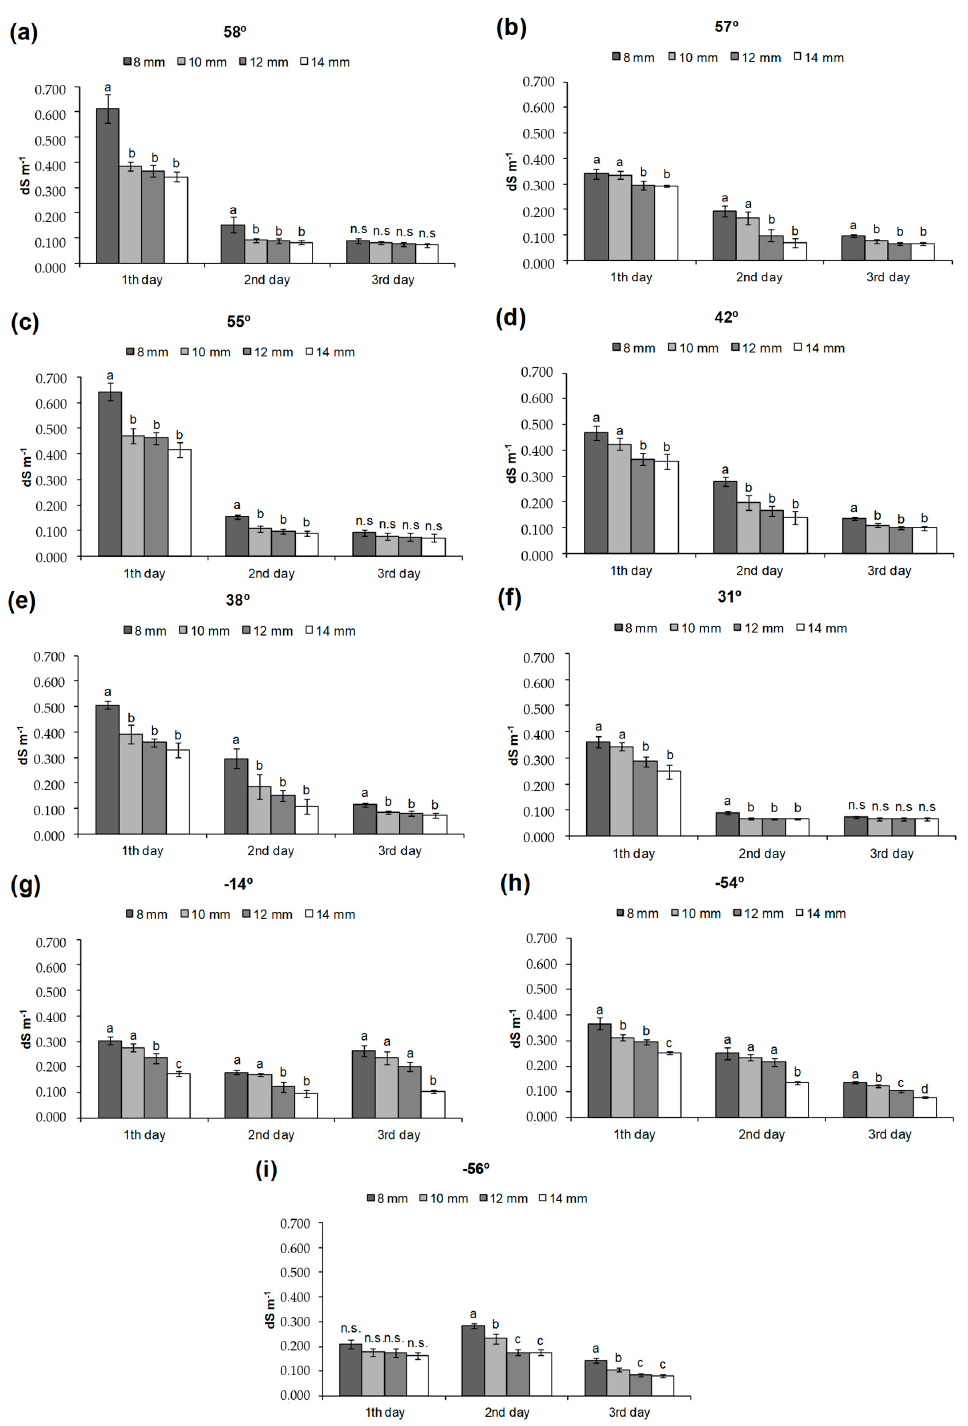
Figure 6. Effect of irrigation volume at each mean leaf angle on the leachate electrical conductivity (dS m − 1 ) of seedlings. ( a ) Genipa americana L. (58°), ( b ) Magnolia ovata (A.St.-Hil.) Spreng. (57°), ( c ) Psidium cattleyanum Sabine (55°), ( d ) Moquiniastrum polymorphum (Less.) G. Sancho (42°), ( e ) Lafoensia pacari A.St.-Hil. (38°), ( f ) Esenbeckia leiocarpa Engl. (31°), ( g ) Guazuma ulmifolia Lam. ( − 14°), ( h ) Heliocarpus popayanensis Kunth ( − 54°), and ( i ) Croton floribundus Spreng. ( − 56°). For each mean leaf angle and evaluation day, means with the same letter are not significantly different from each other according to Scott–Knott’s test ( p < 0.05), n.s.—not significant. Error bars indicate standard error.